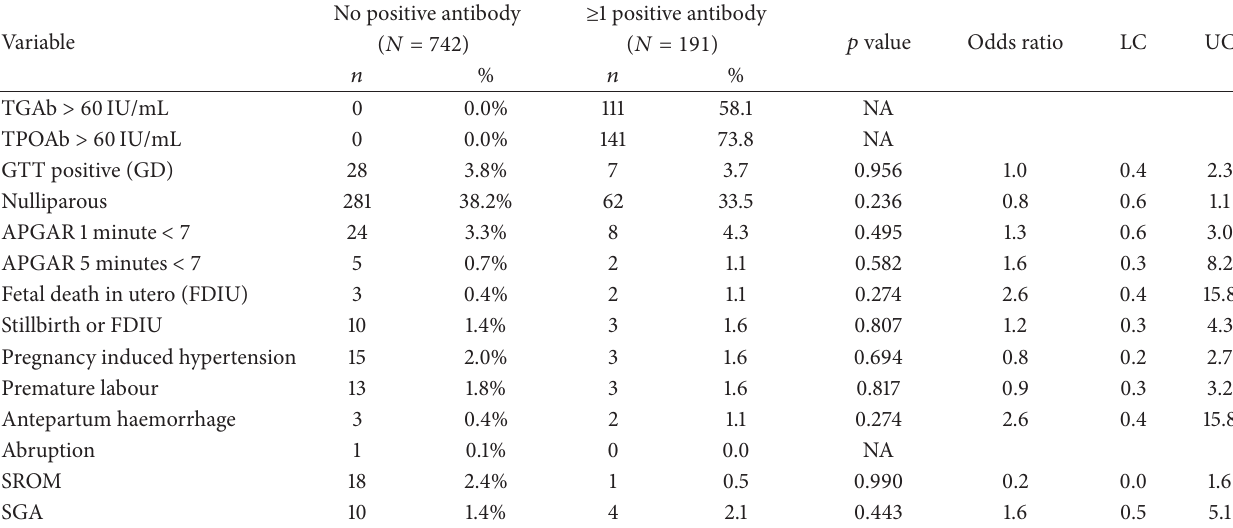
Table 3: Pregnancy outcome with any raised antibody and with TSH < 2.5